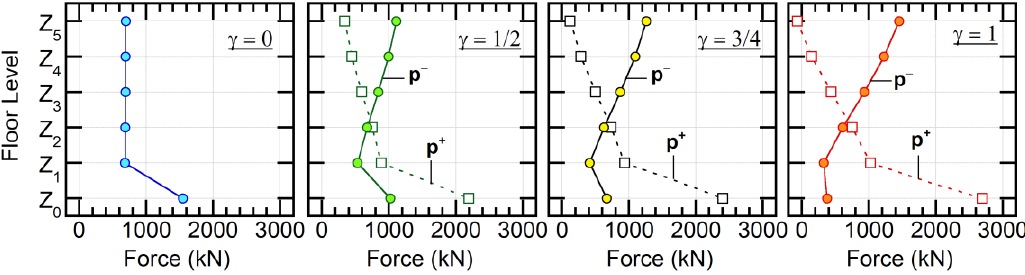
Figure 15. Examples of calculated horizontal-force distributions for Model-05 (Art-S, 100%).